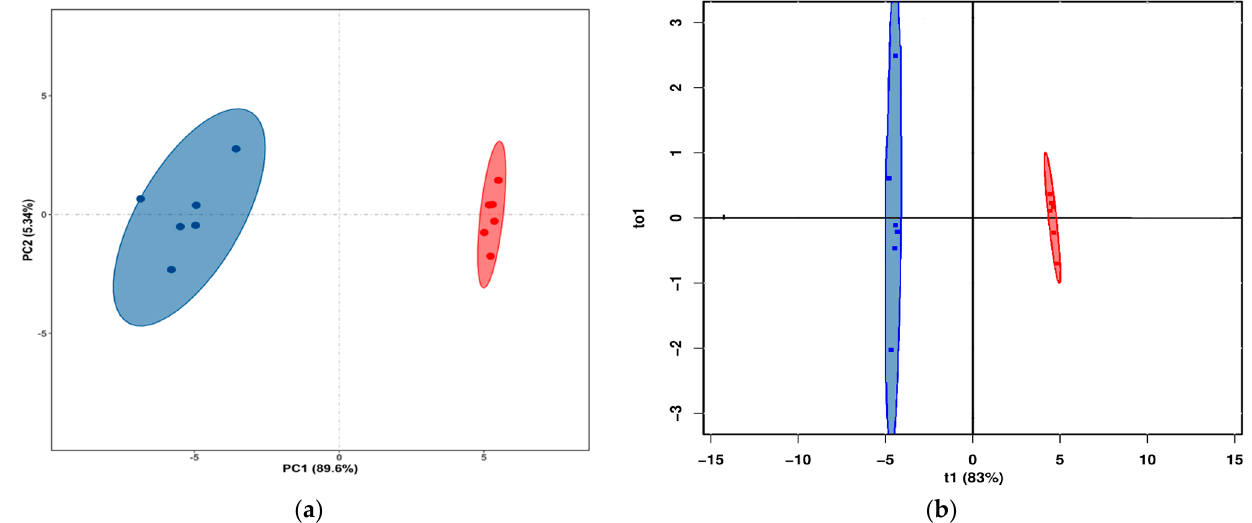
FC represents fold change, which is the ratio of the average relative lipid concentration in the LD of SF yaks to that of GF yaks; PE represents phosphatidylethanolamine; PC represents phosphatidylcholine; TG represents triacylglycerol; PI represents phosphatidylinositol.